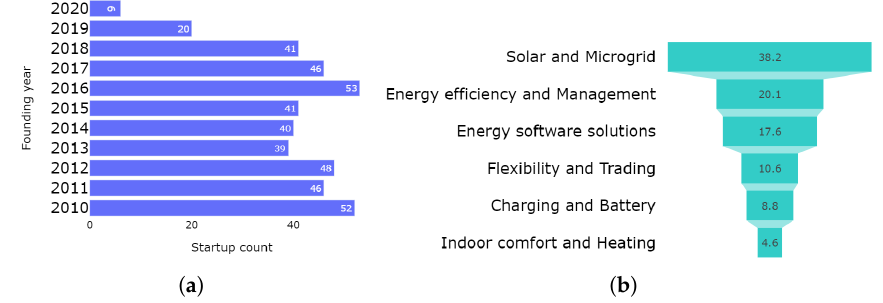
Figure 4. Startups distribution by ( a ) Founding year ( b ) Category (in